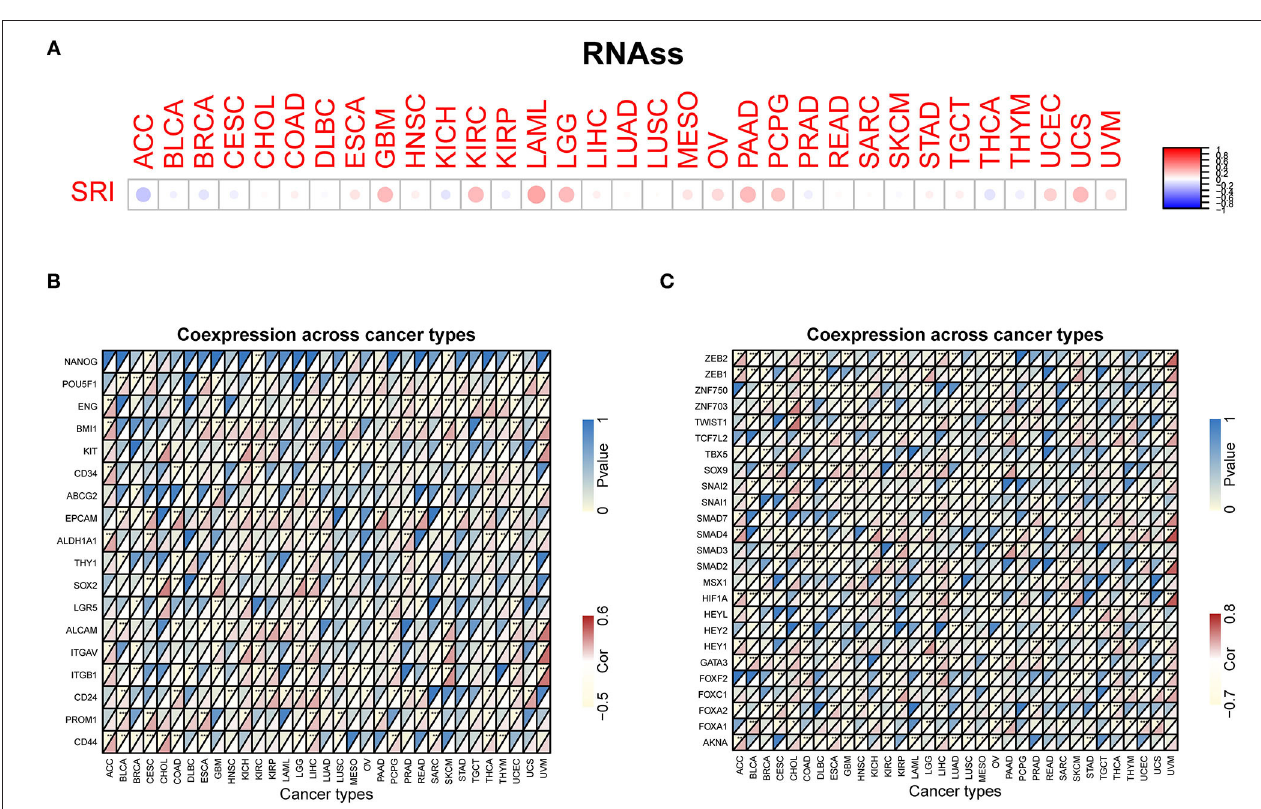
FIGURE 7 | Correlation of the SRI expression with stemness and EMT-related genes in cancers. (A) The SRI expression associated with RNA stemness score (RNAss) in different cancers. The red dots indicate a positive correlation and the blue dots indicate a negative correlation. RNAss, RNA stemness score; a heatmap indicating the correlation between the SRI expression and cancer stem cell markers expression (B) , EMT-related genes expression (C) . For each pair, the top left triangle represents the P -value, and the bottom right triangle represents the correlation coefficient * P < 0.05, ** P < 0.01, and *** P < 0.001.